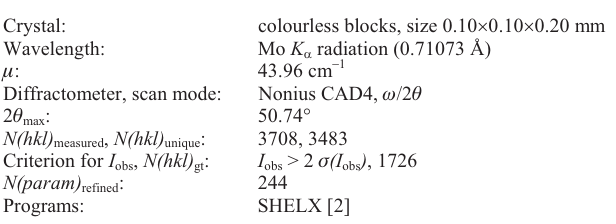
Table 1. Data collection and handling.